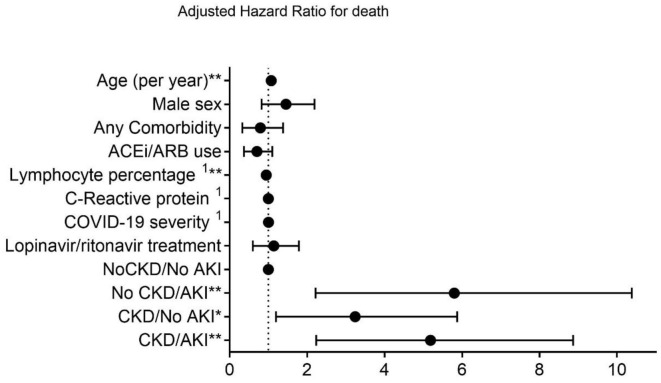
Adjusted proportional hazards model for death. AKI, acute kidney injury; CKD, chronic kidney disease. *p < 0.05, **p < 0.001.